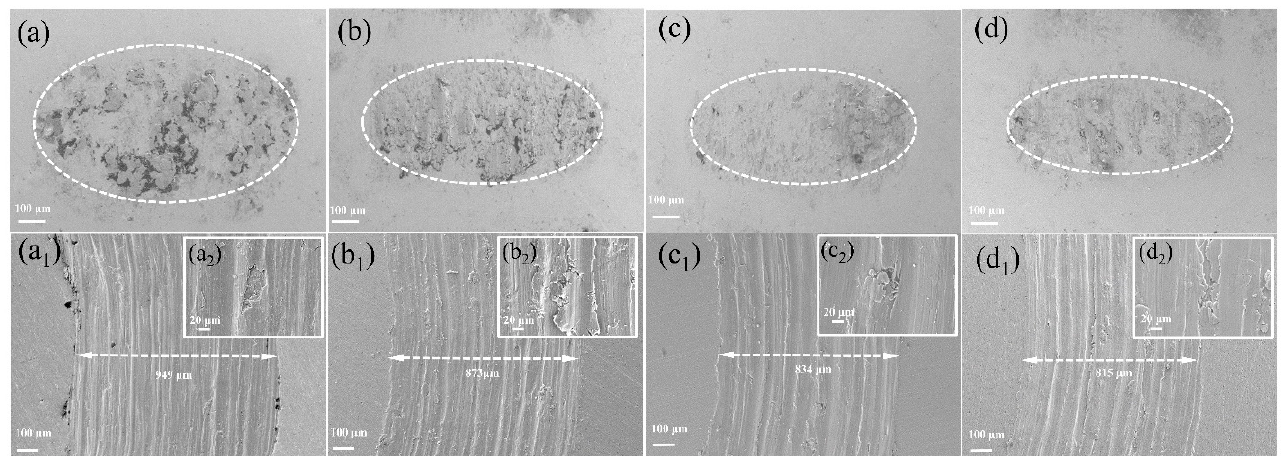
Figure 8. SEM images of worn surface of steel balls and the Ti6Al4V disc lubricated by ultrapure water ( a , a 1 , a 2 ), L-BP ( b , b 1 , b 2 ), M-BP ( c , c 1 , c 2 ), and BPQDs ( d , d 1 , d 2 ) (10 N, 150 rpm, 0.075 wt.%).